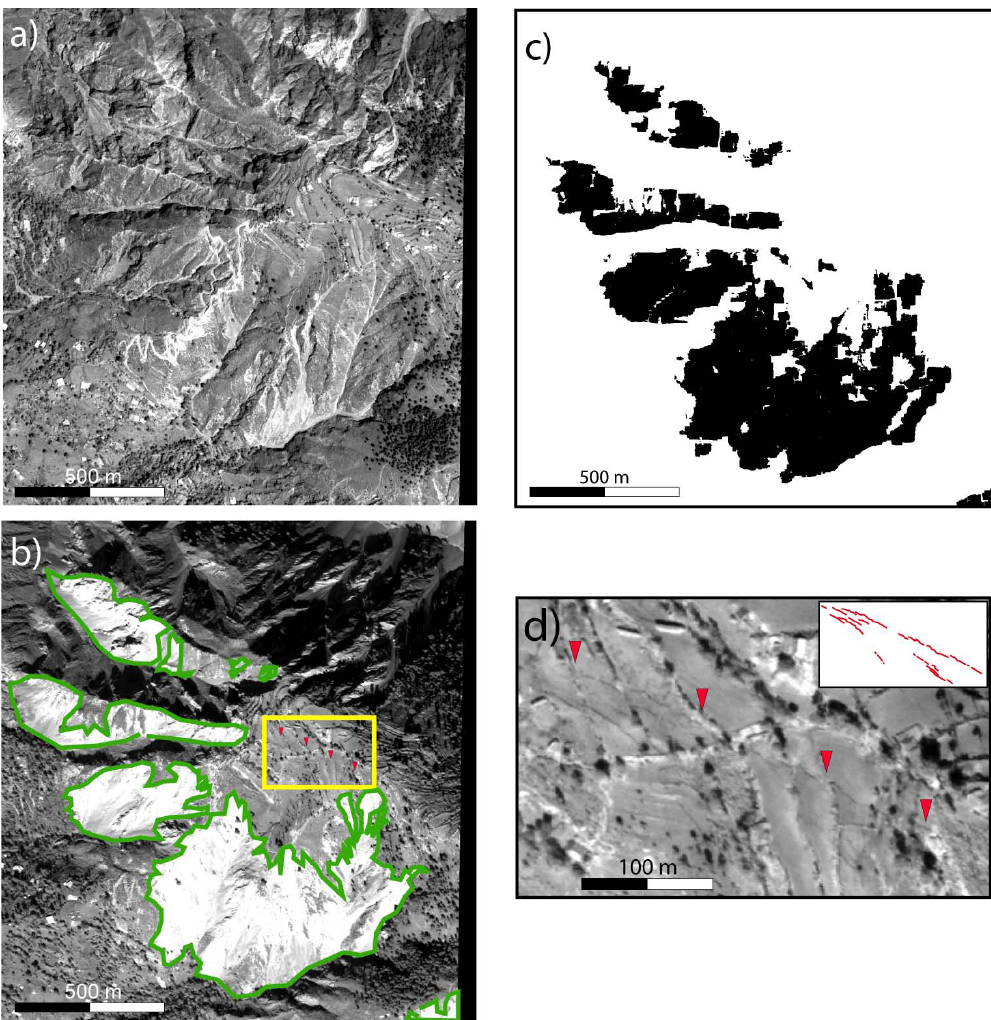
Fig. 5. (a) Pre-event image (13 August 2004) centred on the slope east of Muzaffarabad; (b) post-event image (22 October 2005) of the same area where surface breaks are marked by red triangles and landslides areas are contoured with a green line by visual inspection. Yellow rectangle is the area shown in the detail of inset (d). (c) Landslides (black areas) occurring in the area detected by the automatic classification; (d) detailed view and sketch of the surface breaks (0.6–1m width of linear